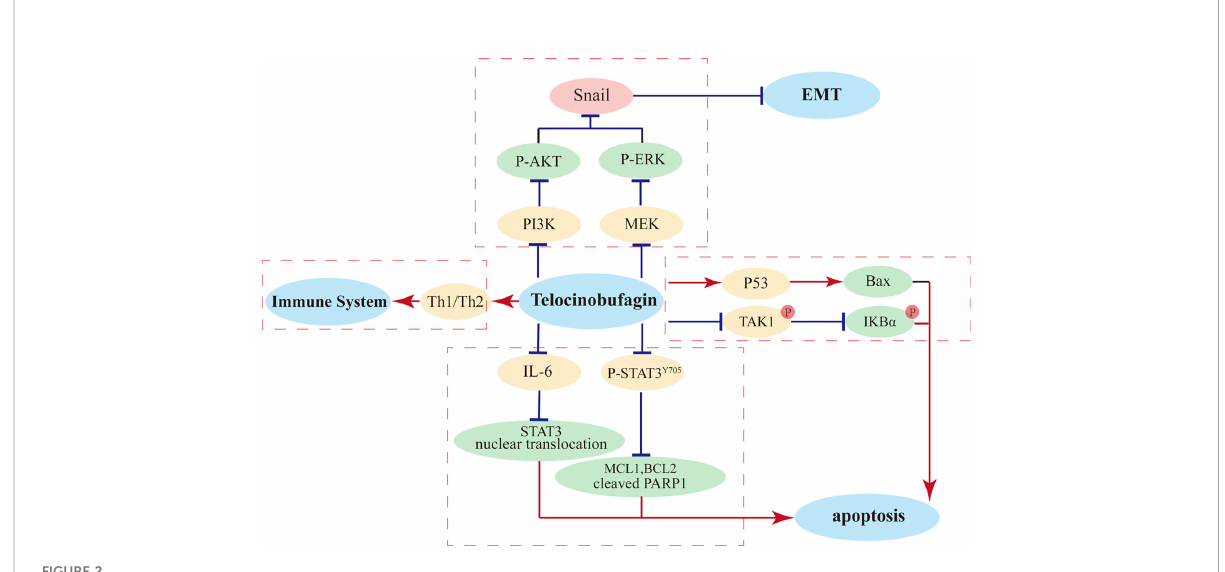
FIGURE 2 The primary mechanisms for TBG induced anti-tumor